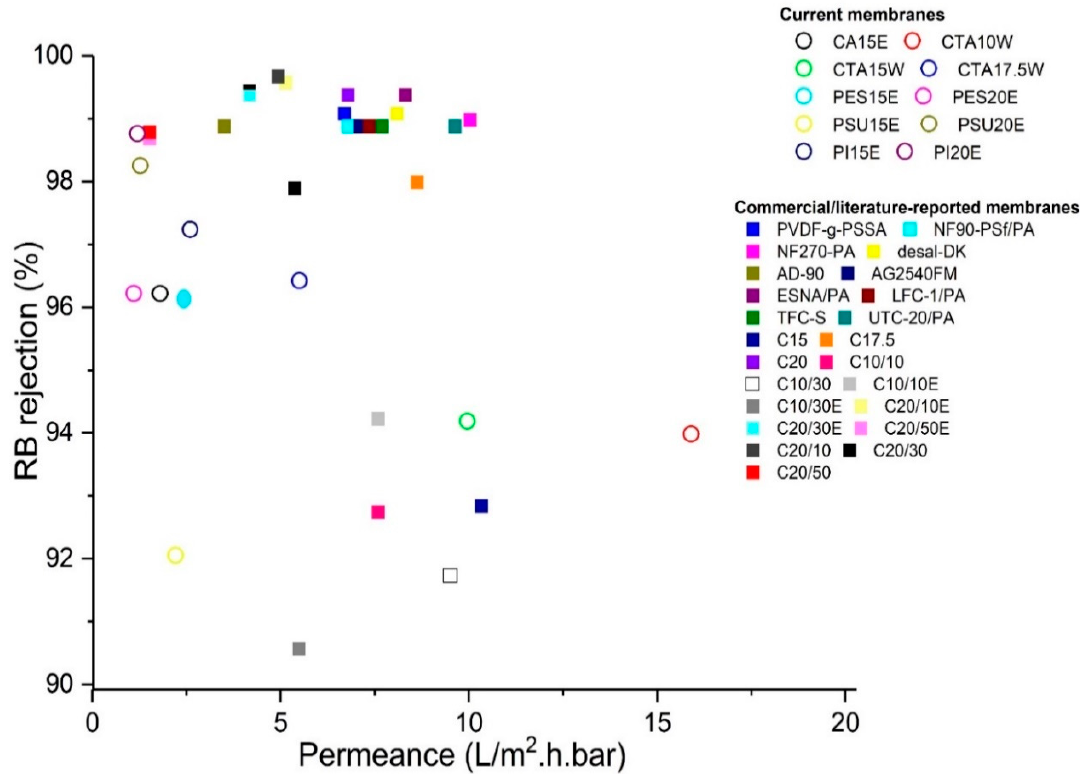
Figure 14. Rejection-permeance plot of nanofiltration (NF)-membranes from current work and their comparison with a selection of commercial or literature-reported membranes using a RB/H 2 O feed solution .